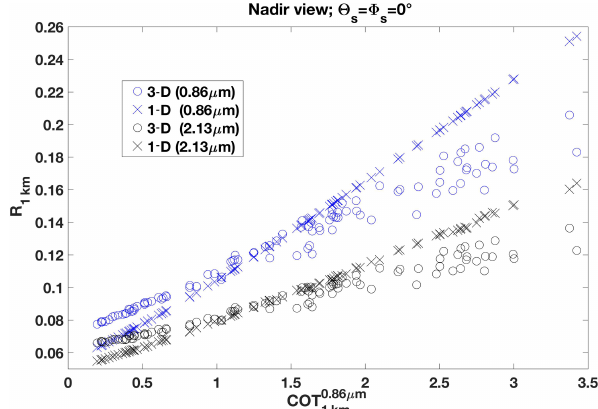
Figure 5. Solar reflectances at 0 . 86µm (blue) and 2 . 13µm (black) at 1km spatial resolution computed in 3-D (circles) and in 1-D (crosses). We choose to show these reflectances at 1km to not over- load the plot with too many points at finer spatial resolutions, but the effect is the